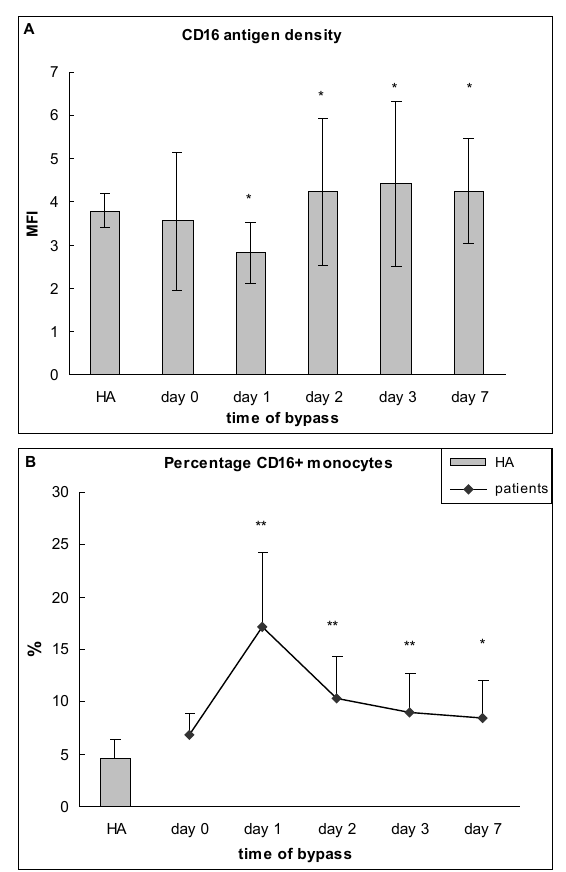
Figure 3. CD16 expression on peripheral blood monocytes before and after CABG. Results, presented as MFI (A) and percentage positive cells (B) are compared with controls (HA). Statistical significance: within-group comparison with baseline: * p<0.01, ** p < 0.0001.